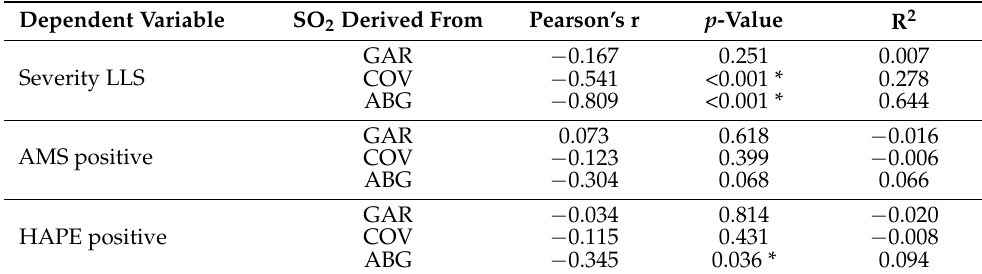
Table 3. Correlation and linear regression analysis between SO 2 -derived variables from different devices and high-altitude illness.